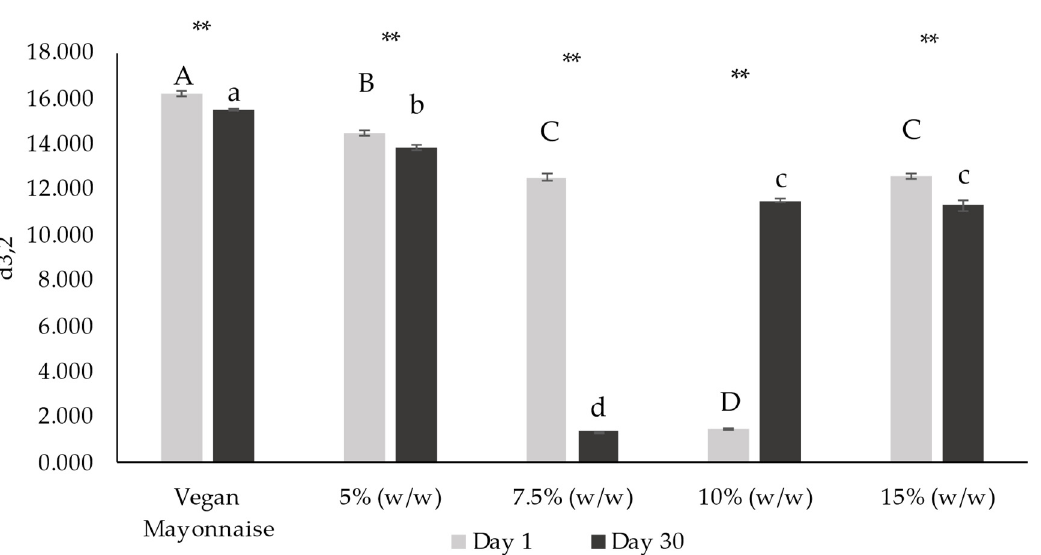
Figure 11. Sauter diameter (d 3,2 ) from droplet size distribution of emulsions with 5, 7.5, 10 and 15% ( w / w ) of miso paste and standard emulsion, measured 1 and 30 days after emulsion preparation. Different letters indicate significantly different results ( p < 0.05) according to Tukey test. Two asterisks represent non significantly ( p > 0.05) and significantly ( p < 0.05) different results, respectively, according to the t -Test.